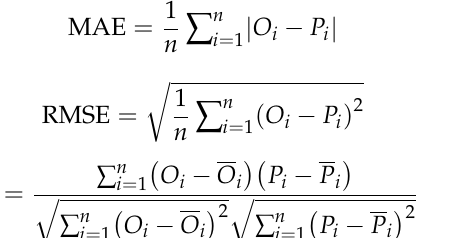
Table 1. Model comparison between the DCRNN model and baseline models in the PM 2.5 forecasts.